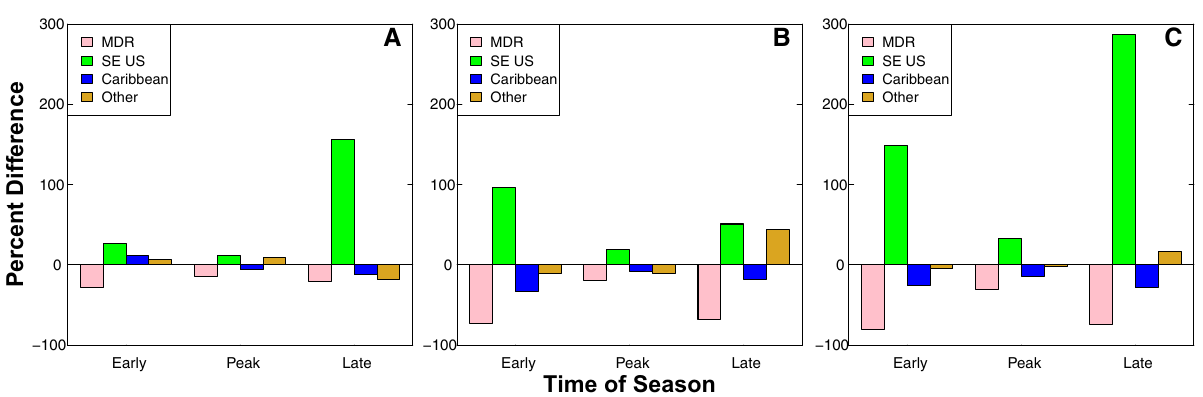
Figure 4. Bar graphs displaying the proportional change in TC genesis within each region during each part of the season. Bar graphs of the proportional change across ( A ) modern era compared to pre-industrial era, ( B ) future era compared to modern era, and ( C ) future era compared to pre-industrial The distributions of 850–250 hPa vertical wind shear at the time of genesis indicate a decrease in shear across all regions by the future era, with the greatest decreases occurring in the Caribbean (Fig. S3). Throughout the season as a whole, future SE US wind shear anomalies are higher (i.e., decrease less or increase more compared to the modern baseline) relative to changes in MDR or Caribbean shear values (Fig. 5A–C). In the late season, mean shear anomalies indicate slight increases in shear values within the MDR by the future, although the mean